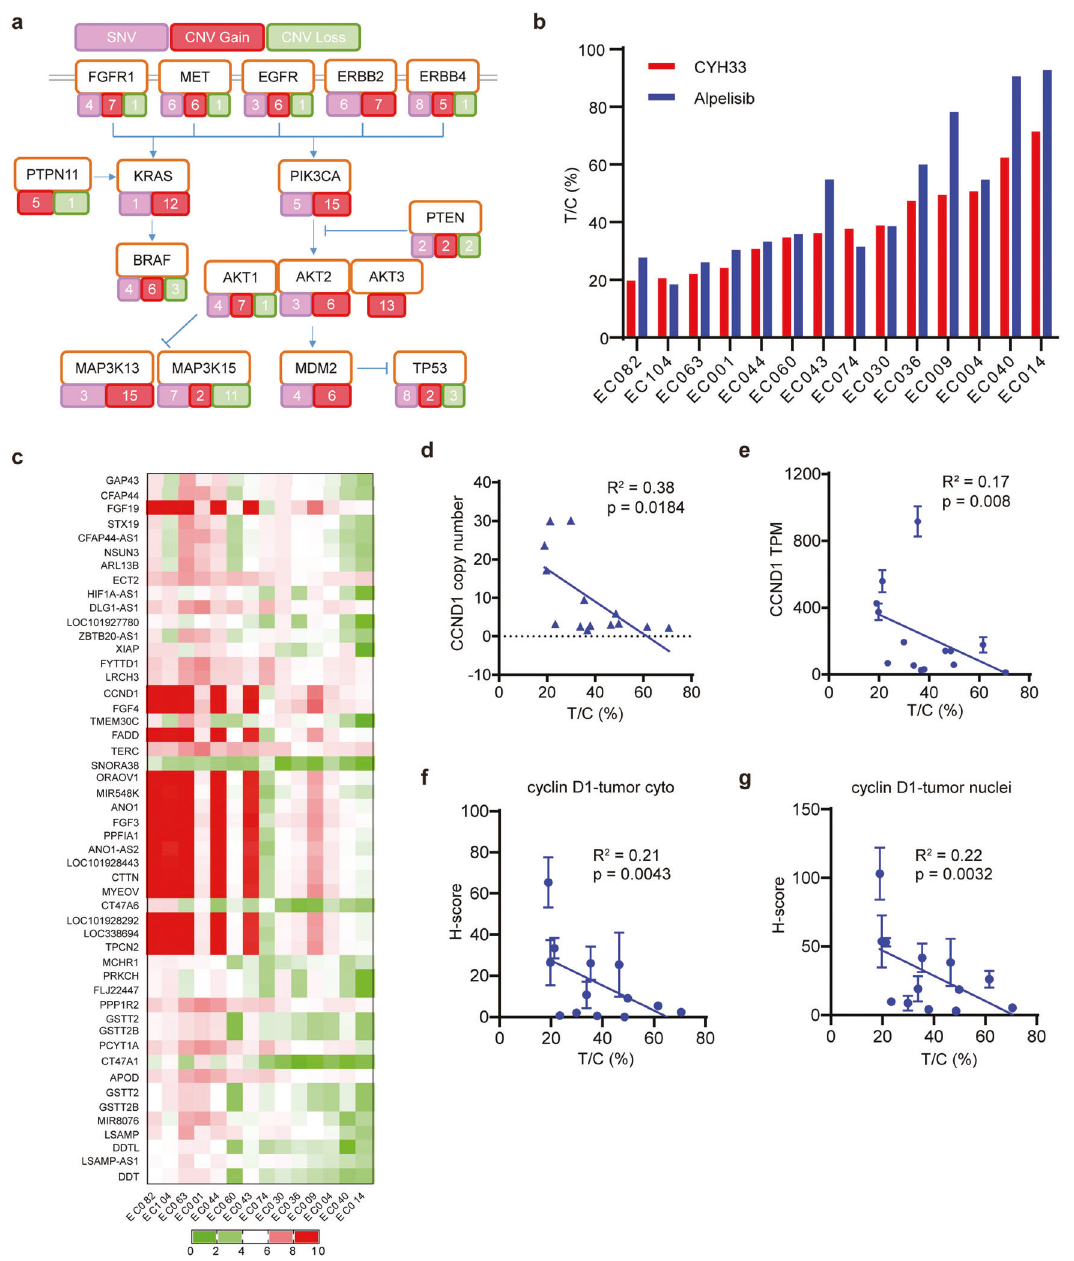
Fig. 2 ESCC PDXs with CCND1 ampli fi cation were more sensitive to CYH33. a Whole genome sequencing of 16 ESCC PDX samples. Alterations in RTK-PI3K pathway were presented indicating the number of PDX samples with SNV, CNV gain or CNV loss. b Randomly grouped BALB/c nude mice bearing ESCC PDXs were orally administered with vehicle ( n = 12), CYH33 (25 mg/kg, once a day, n = 6) or alpelisib (50 mg/ kg, once a day, n = 6). Tumor volume and body weight were measured twice per week, and the treatment to control ratios (T/C) were calculated at the end of treatment. c The correlation of the copy number of whole genome and T/C values obtained in 14 ESCC PDXs was analyzed. Top 50 genes with copy number negatively correlated with the T/C values were presented. d , e Pearson correlation analysis of the T/C values and CCND1 copy number ( d ) or TPM values indicating CCND1 mRNA level ( e ) of ESCC PDXs. f , g Expression level of cyclin D1 was measured by tissue microarray. Pearson correlation analysis of the T/C values and the H-score of cyclin D1 protein in tumor cytoplasm ( f ) or nucleus ( g ) was presented and the CDK inhibitor p27 remained largely unchanged in all cell cycle progression, we examined cell cycle distribution after tested cells, the CDK inhibitor p21 (alternatively p21 WAF1/Cip1 ) treatment of CYH33 for 24 h in this panel of ESCC cells. CYH33 signi fi cantly arrested cells at G0/G1 phase in sensitive accumulated in 3 lines of sensitive cells (Fig. 3d and Supplemen- cells in a concentration-dependent manner, while it possessed tary Fig. S4c). p21 slightly increased in TE-1 cells and even little effect in resistant cells (Fig. 3c). Accordingly, phosphorylation decreased in KYSE450 and Eca109 cells (Fig. 3d and Supplemen- of Rb at S807/811 signi fi cantly decreased after CYH33 treatment tary Fig. S4c). p21 acts as a brake in cell cycle progression by in sensitive cells. No signal for phosphorylated Rb was detected in attenuating the activity of cyclin/CDK complexes to phosphor- TE-1 cells because Rb is de fi cient in this cell line. Though cyclin D1 ylate Rb. We measured the level of p21 in complex with cyclin D Signal Transduction and Targeted Therapy (2023)